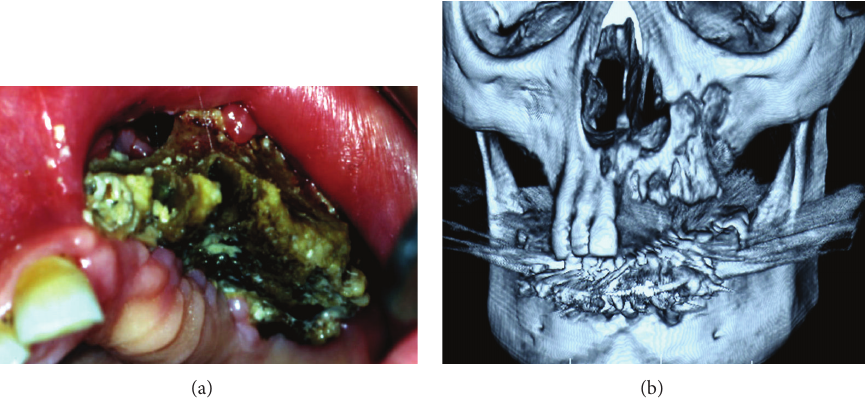
Figure 1: Clinical aspect and multislice spiral CT with 3D reconstruction of Stage III BRONJ involving the maxillary sinus, in a 74-year-old female patient with multiple myeloma, who underwent zoledronic acid therapy.